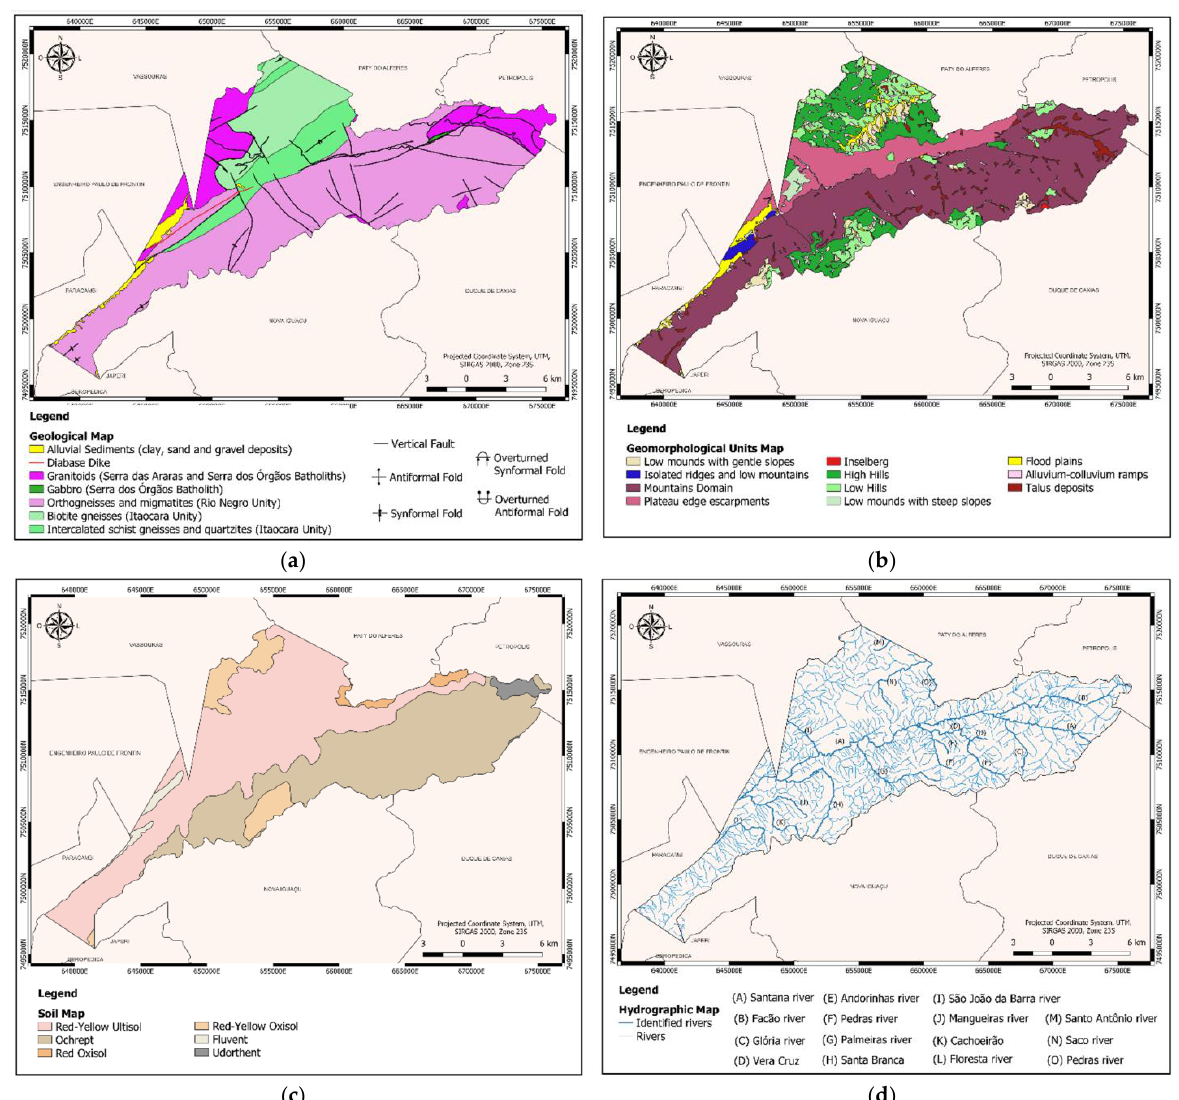
Figure 2. ( a ) Geological map of Miguel Pereira (modified and translated from DRM-RJ, 1982 [46]); ( b ) Geomorphological units map of Miguel Pereira (modified and translated from CPRM, 2017 [47]); ( c ) Soil map of Miguel Pereira (modified and translated from INEA, 2011 [48]); ( d ) Hydrographic map of Miguel Pereira (modified and translated from IBGE, 2018 [49]) . “Identified rivers” are the rivers that are identified and named by IBGE (A – O) . “Rivers” are those without any designation. Source: Gonçalves et al. [23].